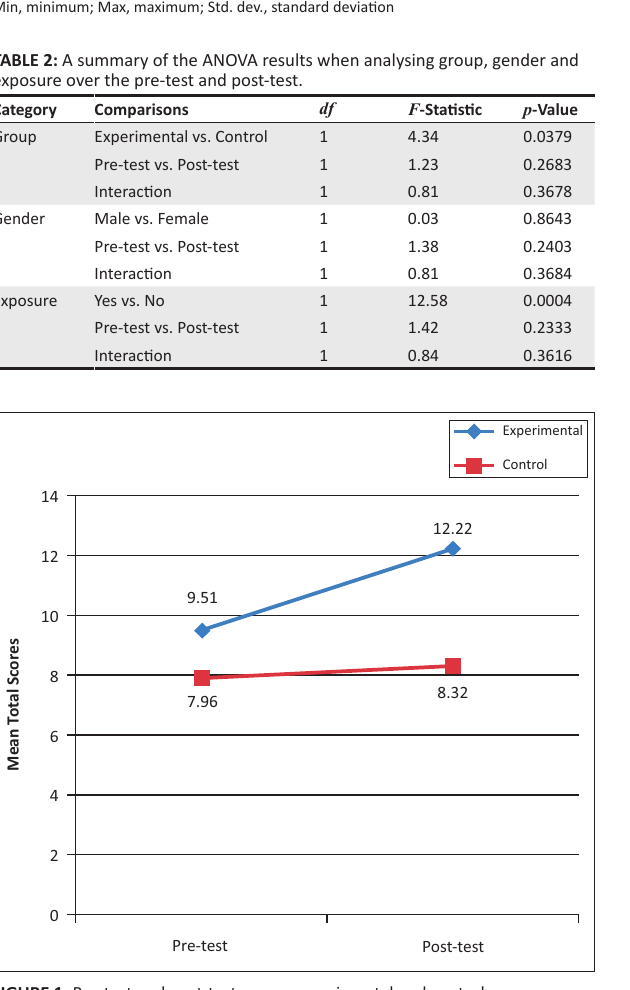
FIGURE 1: Pre-test and post-test scores experimental and control group.